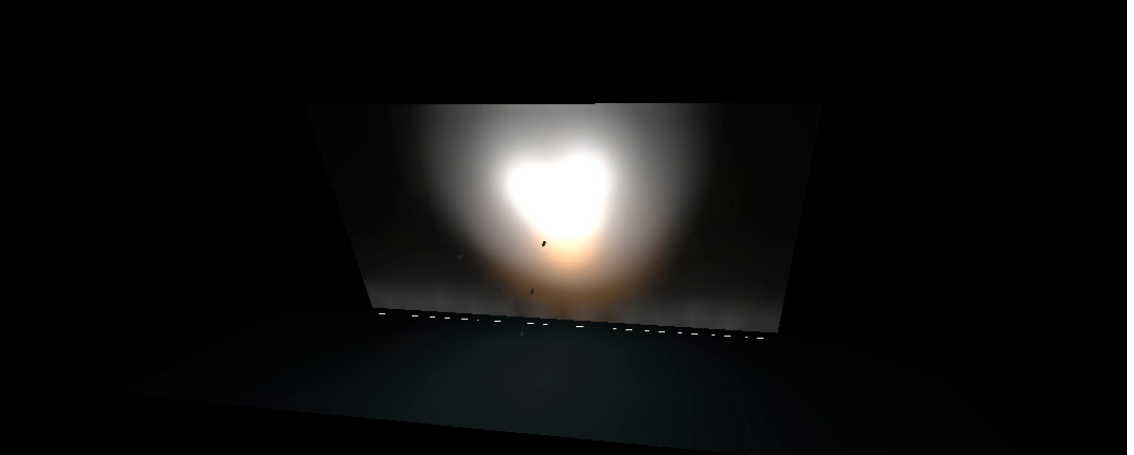
Figure 9. Simulation of visual result of Working Diagram I—Scene 2.